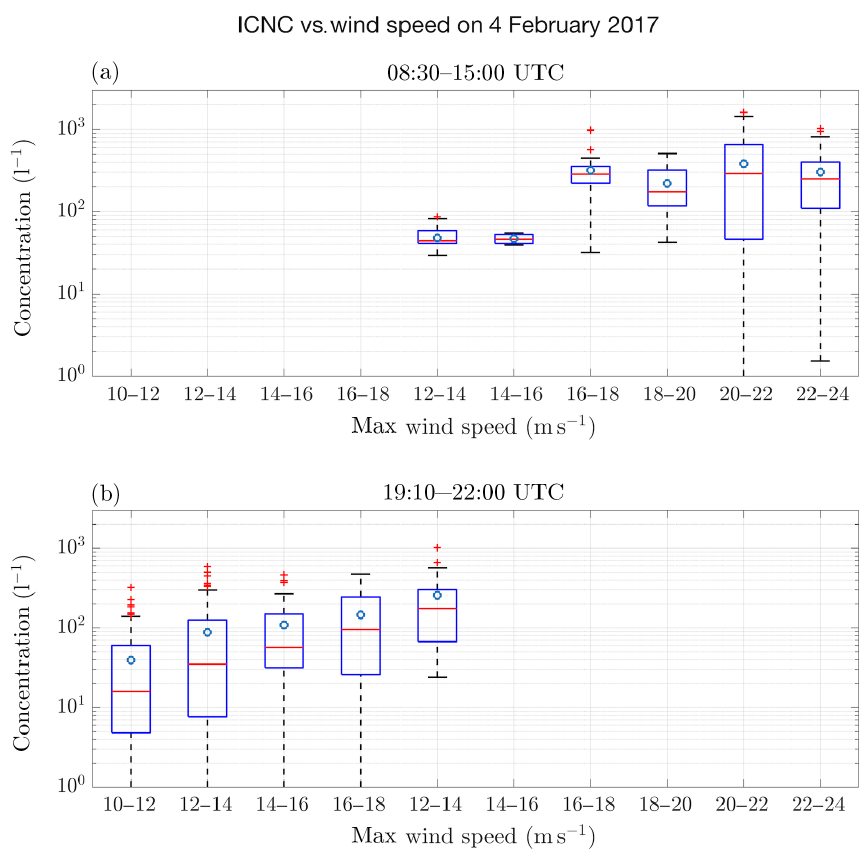
Figure 9. As Fig. 6, but for ICNC as a function of the horizontal wind speed for the time periods between 08:30 and 15:00UTC when the wind direction was from the west–southwest (a) and between 19:10 and 22:00UTC when the wind direction was from the north (b) . The ICNCs from HOLIMO are 1min averages and the wind speeds from the SBO are the maxima in the respective 1min